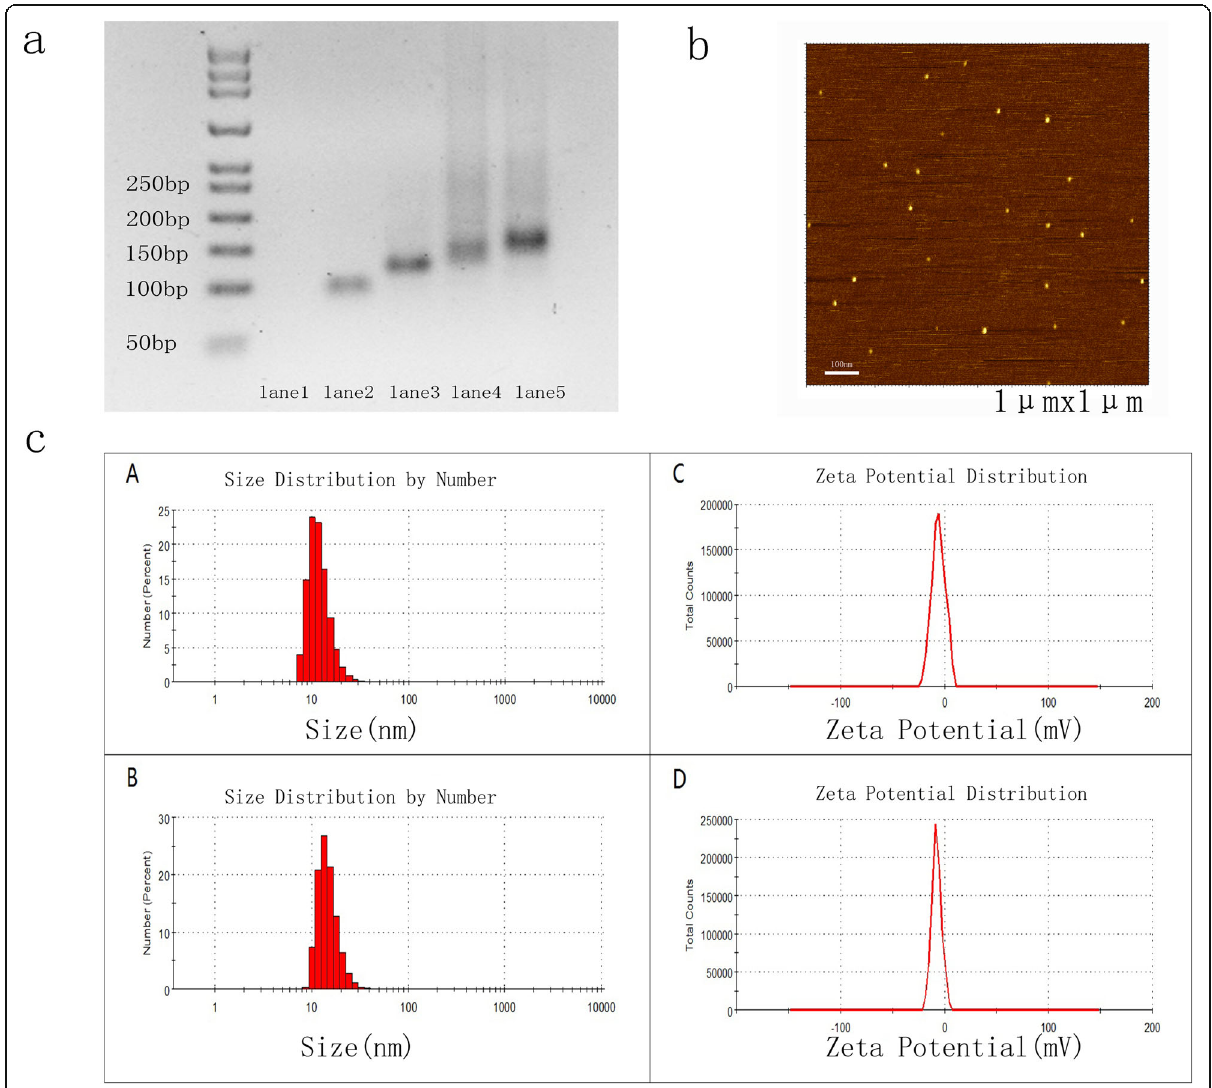
Fig. 1 a Synthesis of the DNA tetrahedron and Gint4.T-TDN. Lane 1: S1; lane 2: S1+S2; lane 3: S1+S2+S3; lane 4: S1+S2+S3+S4 (TDN); lane 5: TDN mixed with Apt-tail (Gint4.T); Apt-TDN. Lane 1 was not visible because nucleic acid dyes cannot properly stain single-strand DNA. b AFM images showed that the heights of the TDN and Apt-TDN were ~ 2 nm. c Determination of the particle size and zeta potential of the TDN and Apt-TDN by dynamic light scattering (DLS). The average particle sizes of the TDN and Apt-TDN were 10.10nm (A) and 13.54 nm (B), respectively. The average zeta potentials of the TDN and Apt-TDN were − 5.69 mV (C) and − 7.3 mV (D),